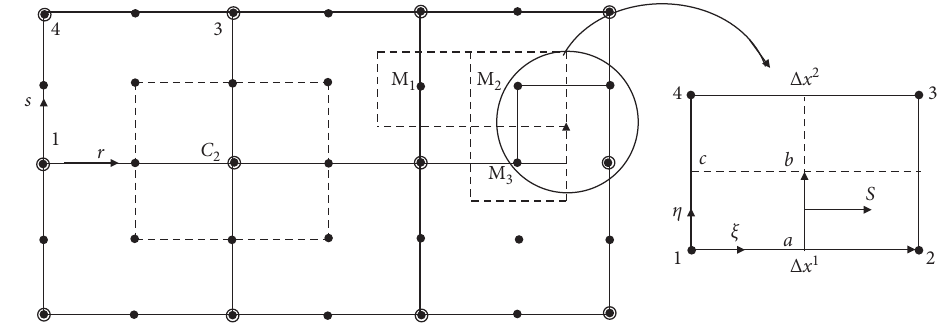
Figure 9: (a) 9-node element; (b) Table 3: The comparison of 1st resonant frequency obtained by ADINA and experiments.